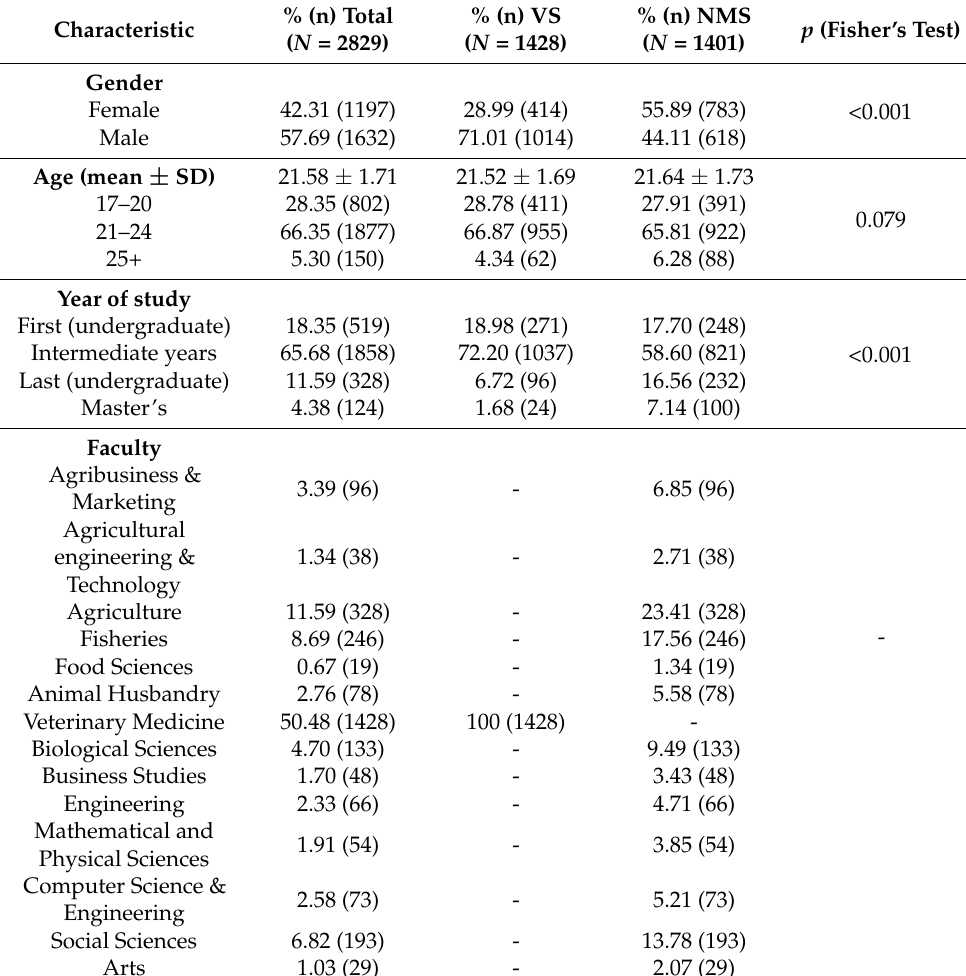
Table 1. Characteristics of